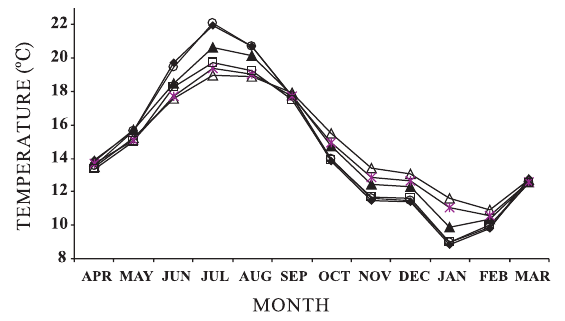
Figure 1. Time-course of monthly temperatures in the litter layer ( ♦♦♦♦♦ ) in P1, at the mineral soil surface in P1 ( ) and P2 ( ΔΔΔΔΔ ), at 16 cm depth in P1 ( ) and P2 ( ) and in the air ( ), from April 2000 to March 2001 ( P1 is the profile with litter layer and P2 without).